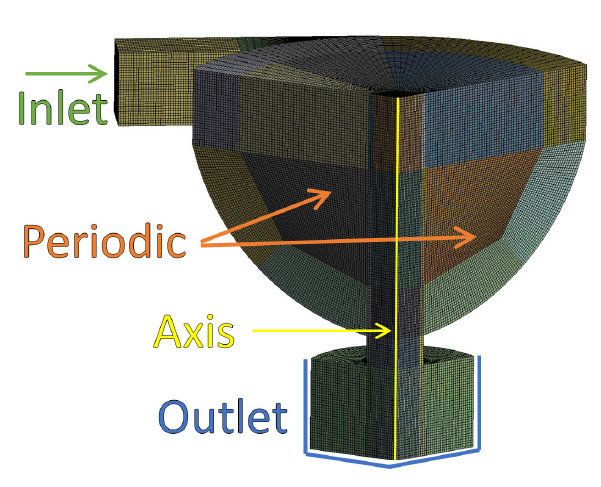
Fig. 4. 3D mesh with boundary conditions .